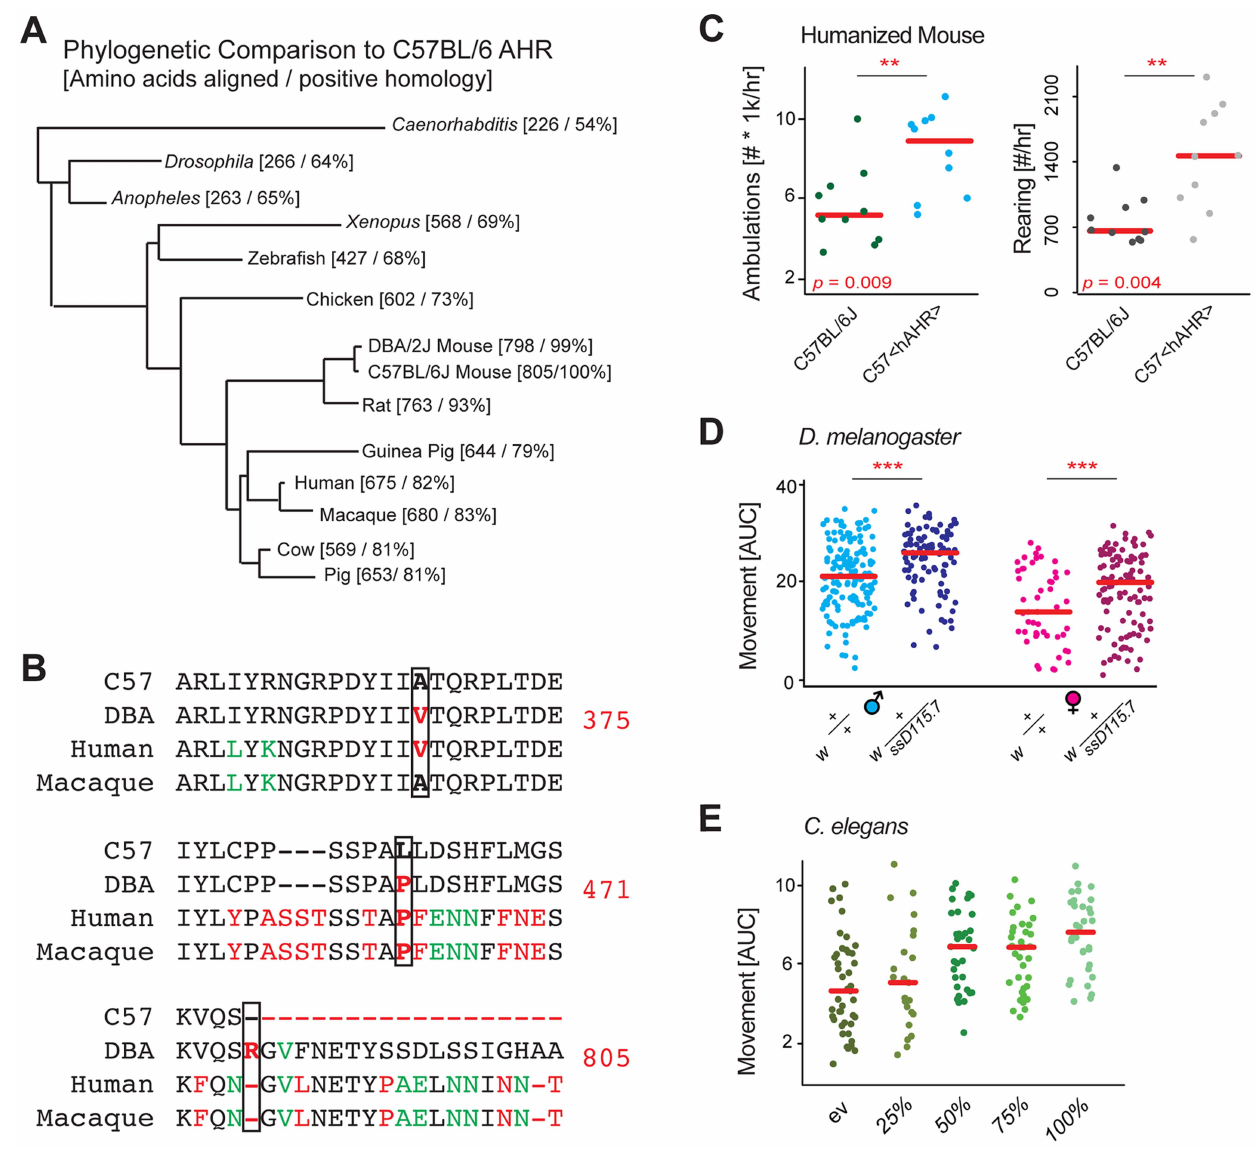
Figure 3. Evolutionary analysis links Ahr to movement. ( A ) Phylogenetic BLAST analysis of mouse Ahr showed that the gene is highly conserved down to simple multicellular animals such as C. elegans , the gene likely has conserved basic metabolic functions. ( B ) Sequence analysis of the three missense mutations of Ahr between B6 and D2 known to have an impact oh AHR activity (375, 471, 805). ( C ) B6 mice with the humanized AHR allele are nearly twice as active as controls. The humanized AHR allele is similar to the D2 allele in many tests of enzymatic activity, with a , 90% + reduction in activity compared to the B6 allele [24]. ( D ) D. melanogaster with a heterozygous deletion allele of the Ahr ortholog ss are also significantly more active than controls. The 50% reduced expression appears to increase movement by about 20% in both males and females. Each comparison is a separate Welch’s t -test with p , 0.001. Females are , 30% less active than males in both instances ( p , 0.001). ( E ) C. elegans treated from early development with RNAi for ahr-1 are nearly twice as active as worms treated with a control vector. Reduced doses of RNAi have intermediary effects on activity. p =2.9e-6 for 100% vs. empty vector (ev).